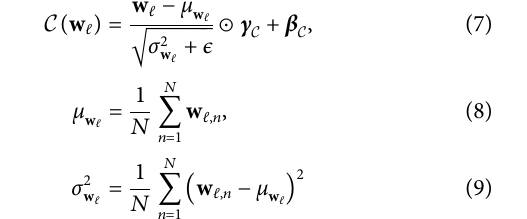
Frontiers in Signal Processing |